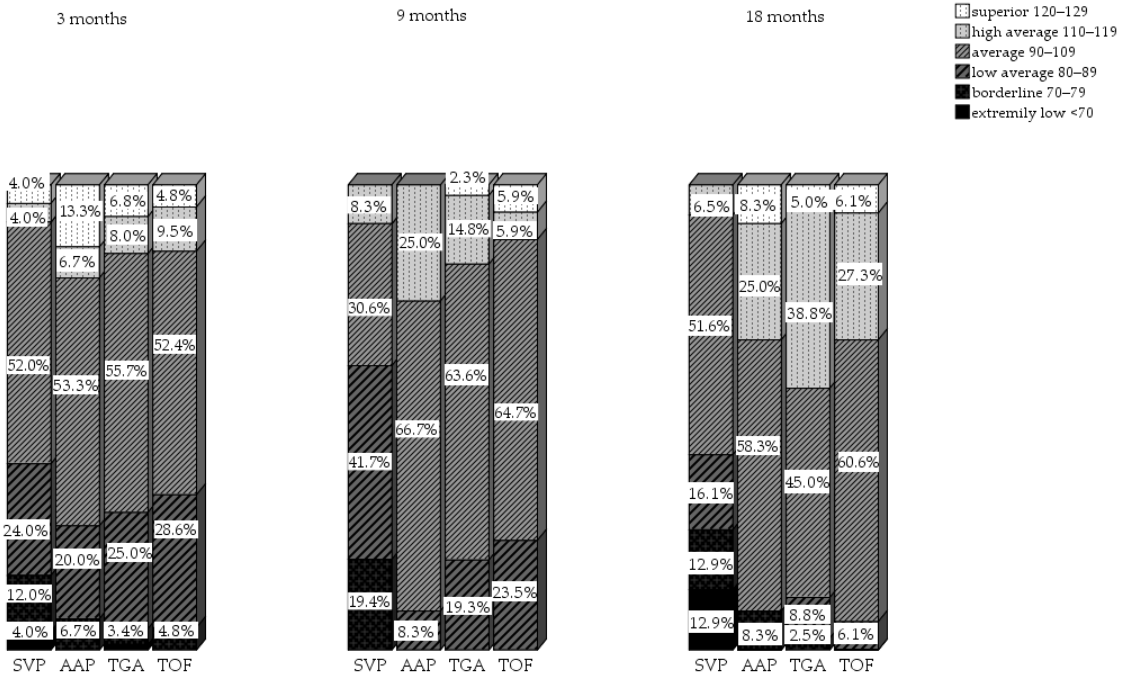
SVP = single-ventricle physiology, TGA = transposition of great arteries, AAP = aortic arch pathology, TOF = tetralogy of